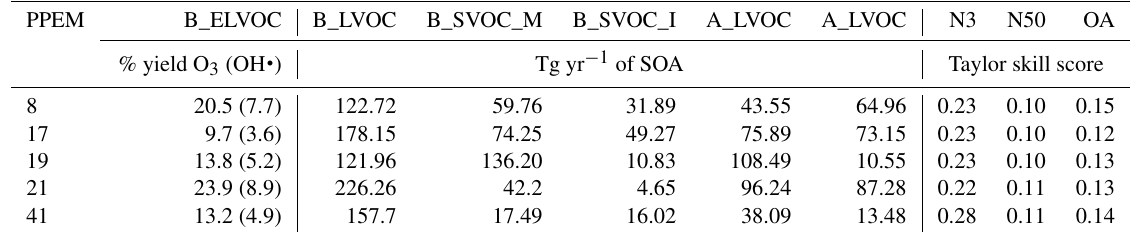
Table 3. Yield of B_ELVOC and SOA (Tgyr − 1 ) for other ox-VOCs with the corresponding Taylor skill scores for five ensemble members that are shaded red for all three outputs N3, N50, and OA in Fig. 13. The parameter combinations used to produce the above ox-VOCs in the ensemble are listed in Table